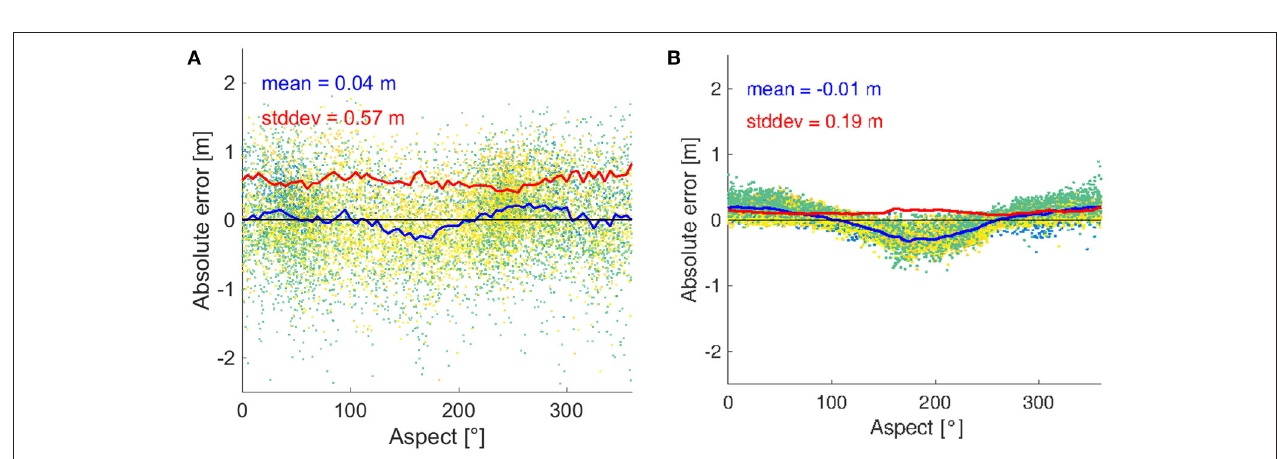
FIGURE 8 | Scatter plot of absolute error of (A) [PSUM] and (B) [PAT] simulations for the winter 2011/12 against aspect. The blue (red) line shows the moving average (standard deviation) for different aspects. The colors indicate land use classification of the grid points (green: rock, yellow: alpine meadow, blue: